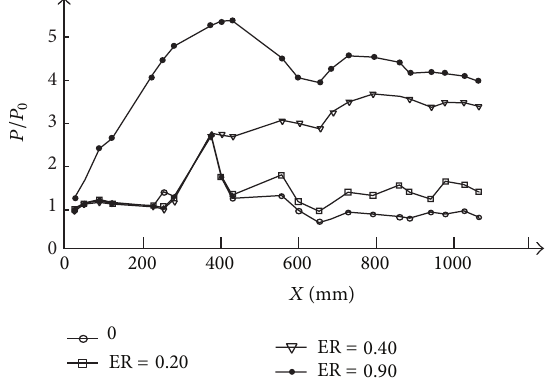
Figure 10: Mach number distribution under different